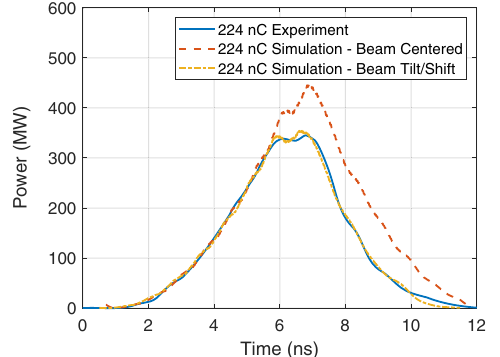
FIG. 25. Experimental trace showing 565 MW of generated output power at 11.7 GHz. The charge measured before entering the structure was 355 nC. The red simulation assumes the bunch train is offset by 0.3 mm per bunch and tilted by 0.21° per bunch.